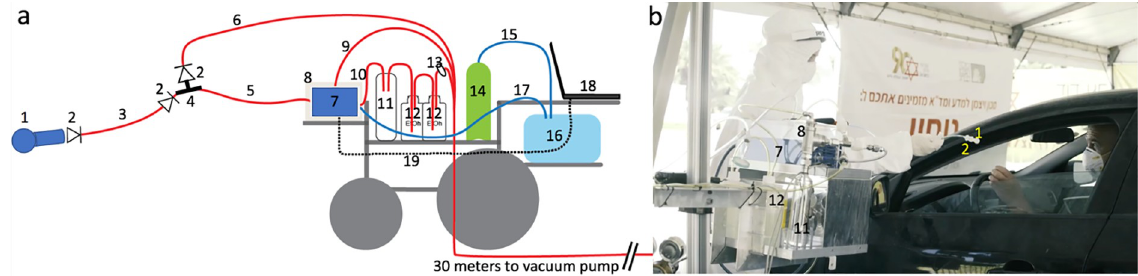
Fig 1. A mobile eNose platform was deployed at a drive-through testing station. A. The detailed logic of this set-up is described in the Methods under “electronic nose set-up”. Components not drawn to scale. 1. The individual disposable sampling valve. 2. One-way flow valve. 3. 1-meter long disposable Tygon tube. 4. The T junction with quick-connect. 5. The eNose inlet tube. 6. The cleaning overflow pull away line. 7. The PEN 3 eNose. 8. Plexiglass mini-hood. 9. Vacuum line pulling from hood. 10. eNose exhaust line. 11. Liquid trap. 12. Ethanol canisters. 13. Filter. 14. Medical grade breathable air canister. 15. Clean air line into air bag. 16. Air bag. 17. Clean reference air inlet to eNose. 18. Laptop. 19. USB line from laptop to eNose. B. The image is a screenshot from the S1 Video, depicting the experimenter handing a sampling valve to a participant. Visible system components numbered as in A. The person in the car is a co-author demonstrating, and not a participant, and informed consent for publication of identifying images in an online open-access journal was obtained. https://doi.org/10.1371/journal.pone.0252121.g001 following settings: Chamber flow = 400ml/min, Flush time = 40s, Zero-point trim time = 10s, Measurement time = 80s. In the following paragraph, numbers in parenthesis relate to the numbered elements in Fig 1. For the current experiment we placed the entire sensing